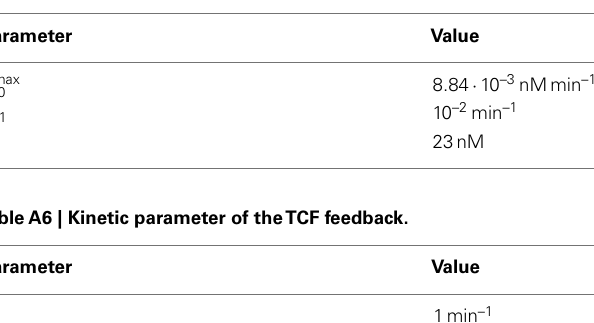
TableA5 |Additional kinetic parameters of the repression motif.